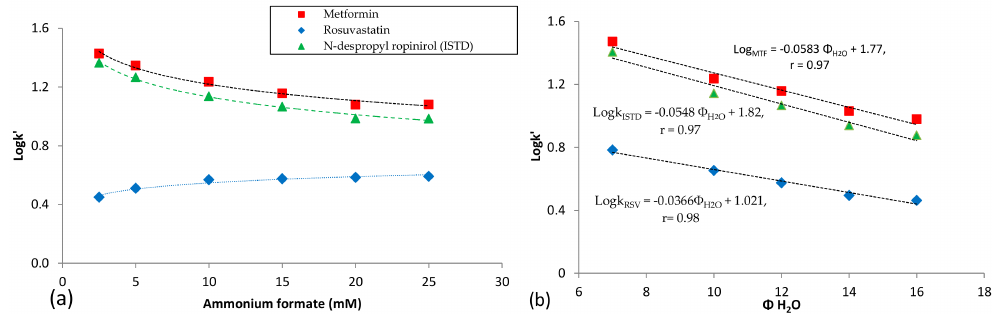
Figure 2. Plots of logk values for rosuvastatin, metformin and N-despropyl ropinirole versus ( a ) the concentration of ammonium formate, and ( b ) the percentage of the water of the mobile phase on an XBridge ® -HILIC BEH analytical column. Data have been obtained from the analysis of human plasma samples spiked with 2500 ng mL − 1 metformin, 50 ng mL − 1 rosuvastatin and 190 ng mL − 1 N-despropyl ropinioro (ISTD).